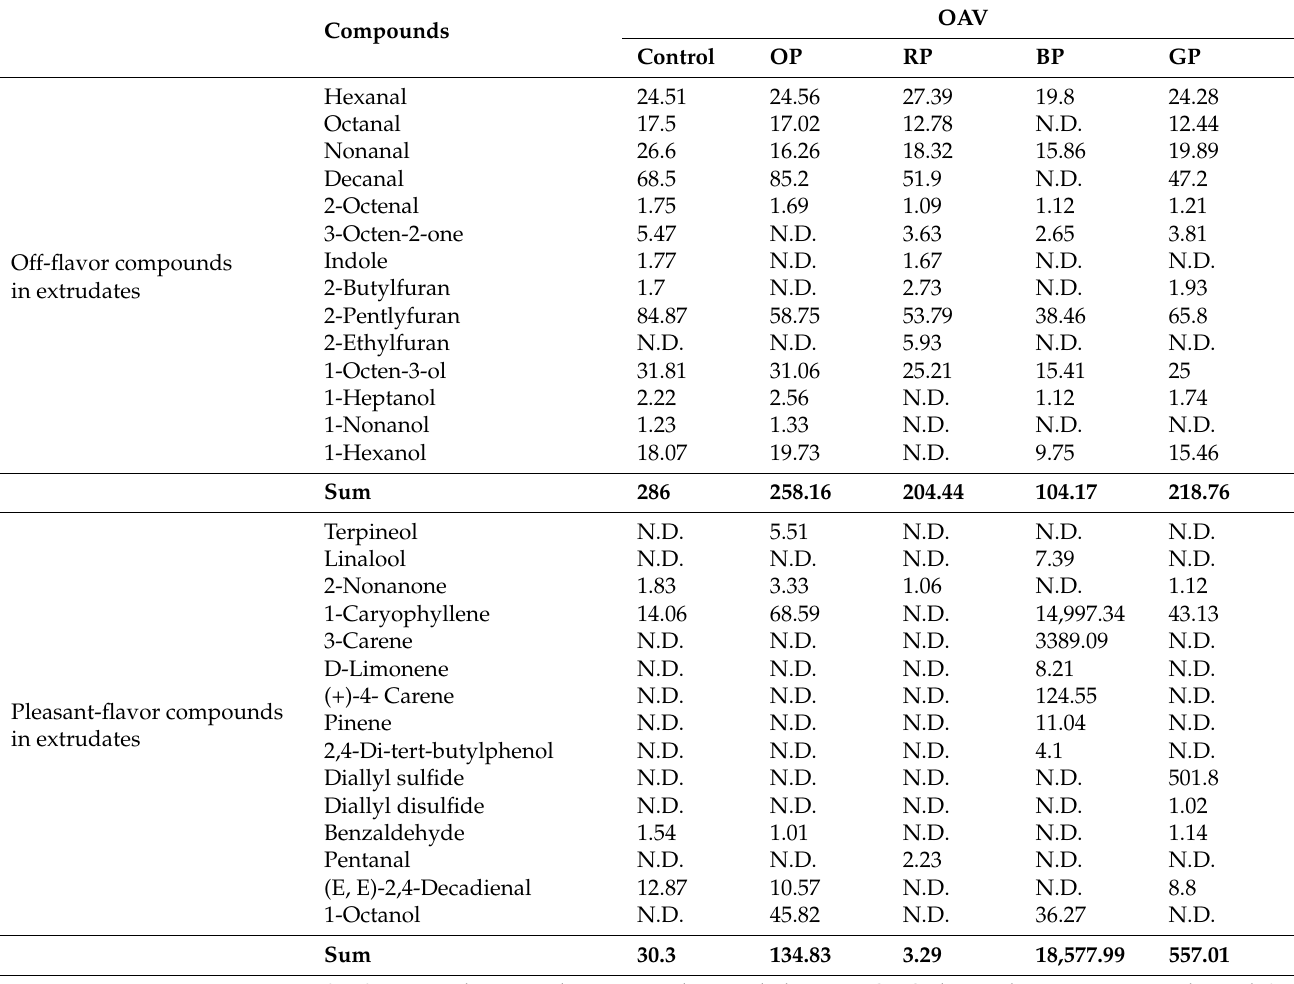
Table 2. Aroma-active compounds in extrudates with and without spices.